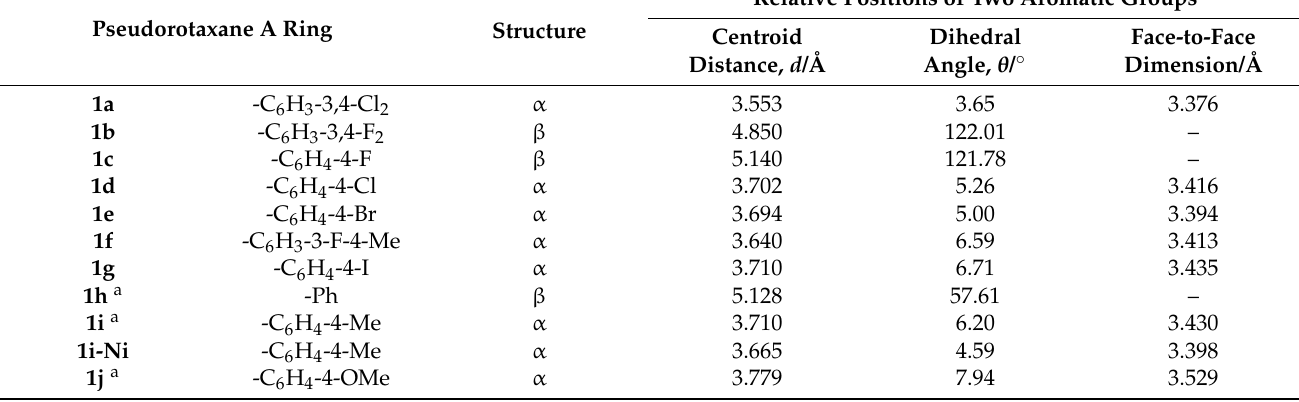
Table 2. Centroid distance and dihedral angles between the two aromatic groups in the axle and cyclic components.